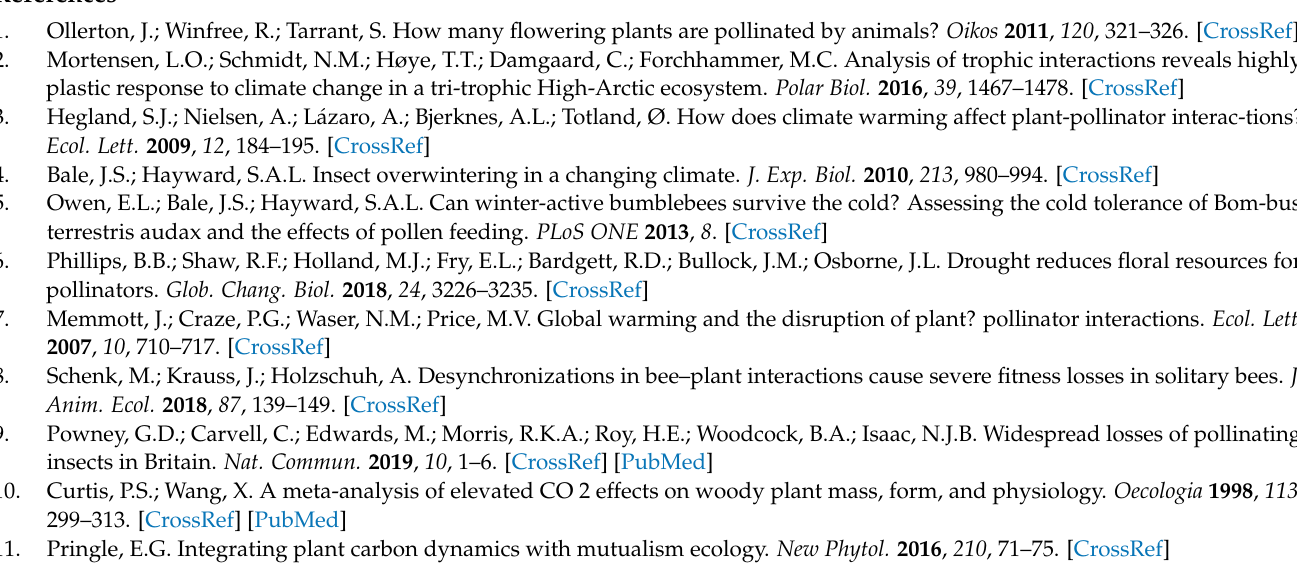
experiment dataset; Table S1: systematic review articles by topic; Table S2: Residuals of ANOVA for treatment against first flowering day of year, mid-flowering day of year and flowering dura- tion; Table S3: Correlation matrix of flowering time and environmental variables; Table S4: All species/species group recorded visiting bluebells during surveys; Figure S1: Mean monthly soil tem- perature for 3 years proceeding observed flowering period; Figure S2: Mean monthly soil